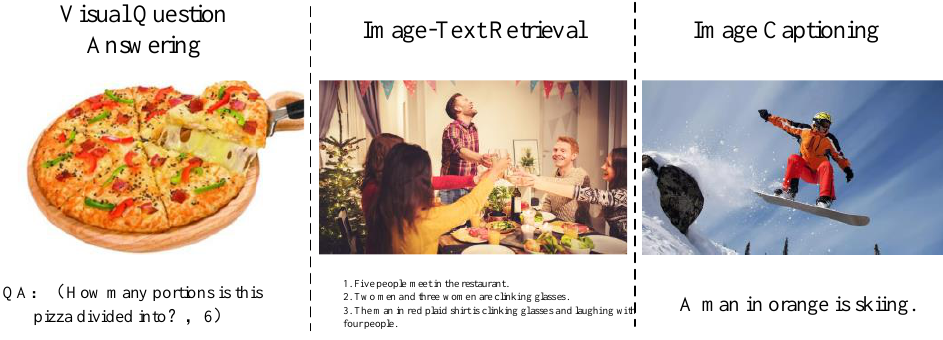
Figure 1. Vision – language task diagram. Figure 1. Vision–language task